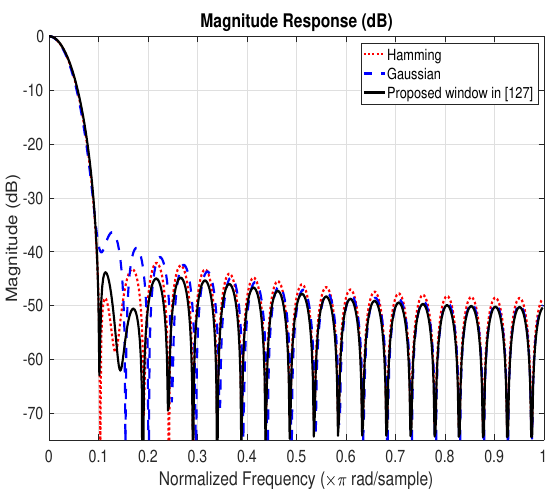
Figure 4. Frequency responses of Hamming window, Gaussian window and the new window proposed in [127].